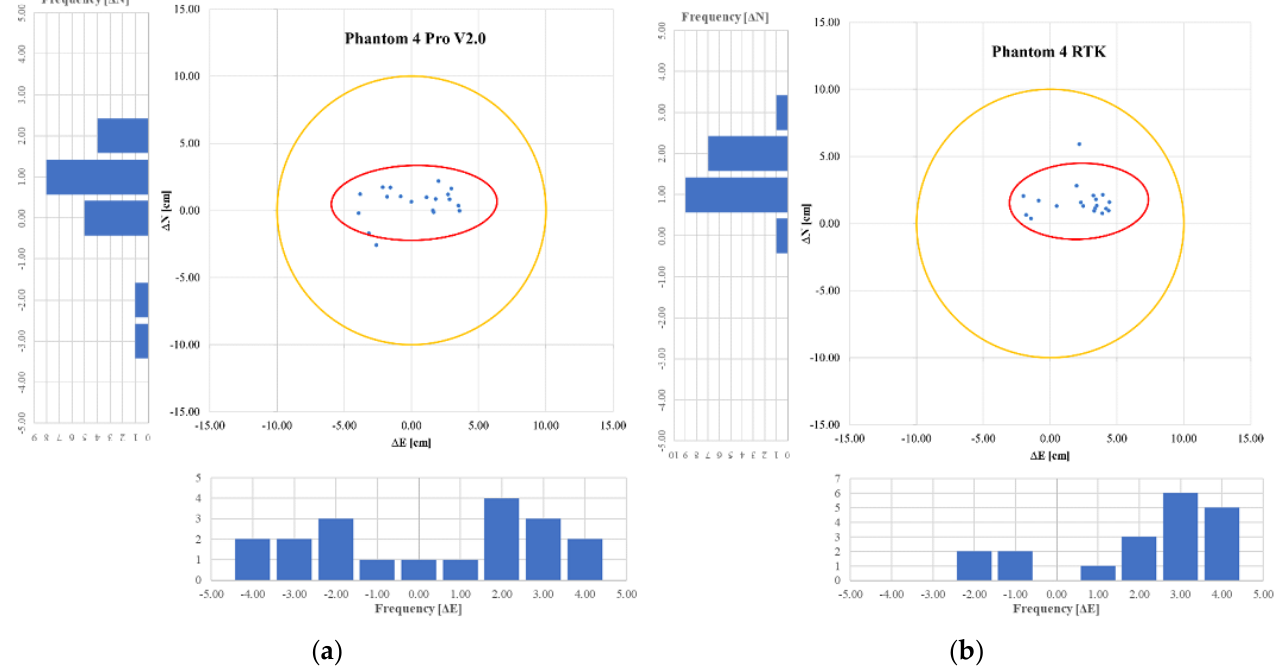
Figure 8. Confidence ellipse—Phantom 4 Pro V2.0 with GCPs at 120 m ( a ); Confidence ellipse—Phantom 4 RTK without GCPs (RTK) at 120 m ( b ).